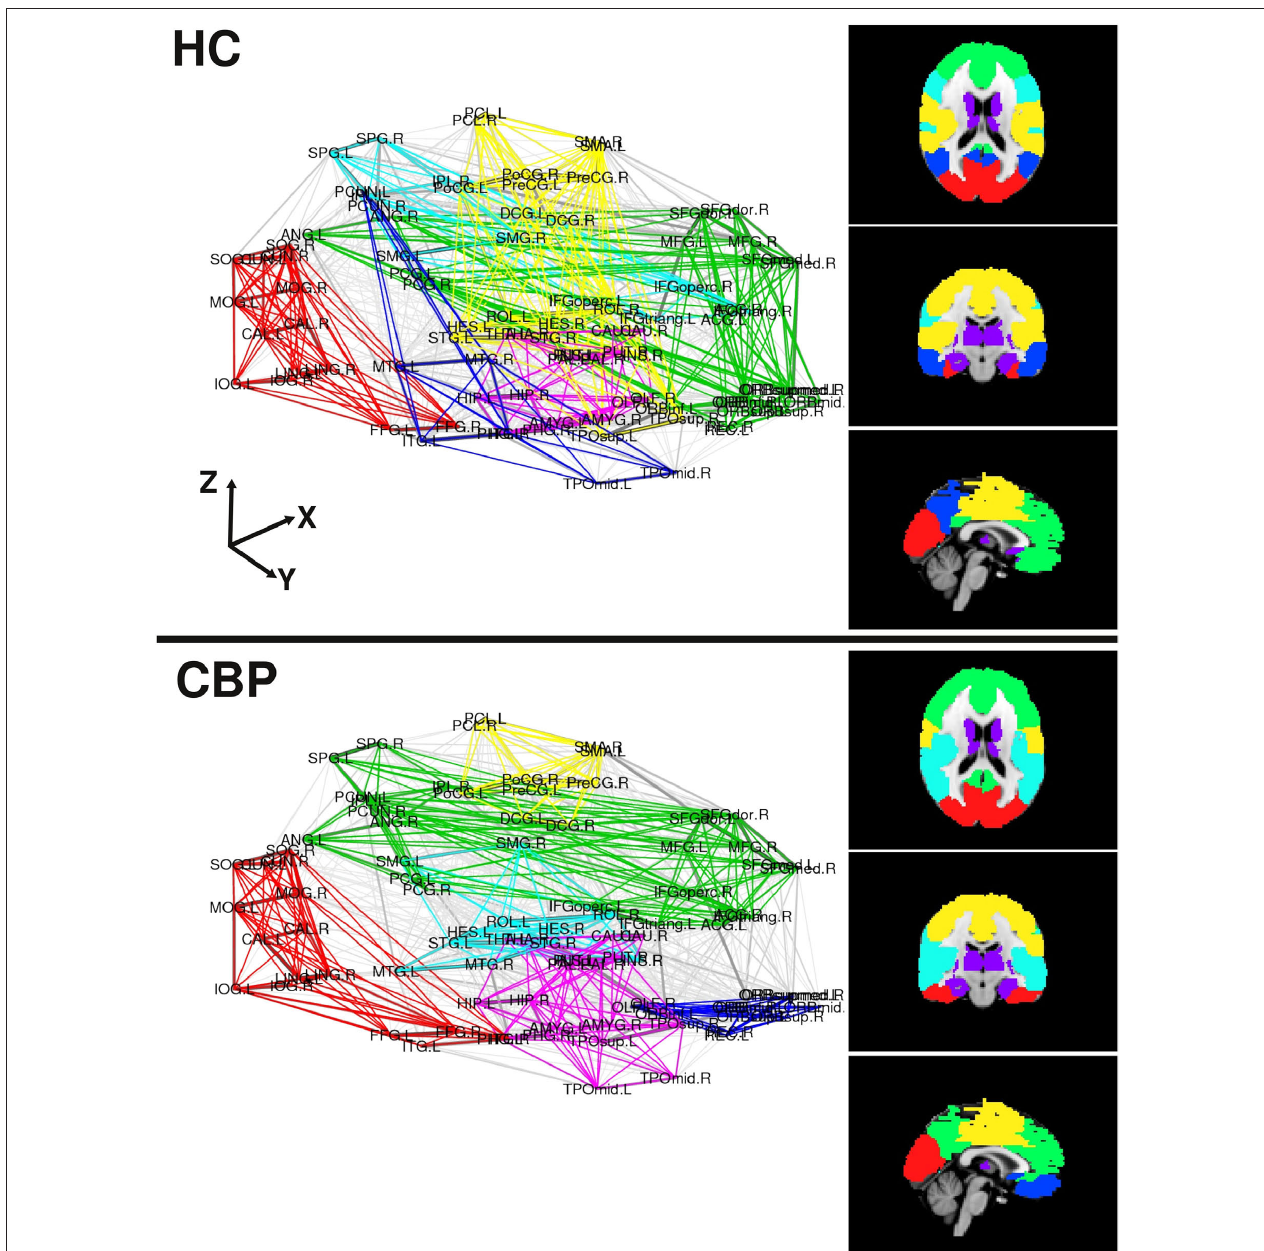
Figure 3 | Community organization for both group networks in two representations. Left panels use the coordinates of the center of mass of each region, the right panels depict axial, coronal and sagittal views of the found communities over a MNI-152 template atlas. Modules are colored as listed in Table A2 (see